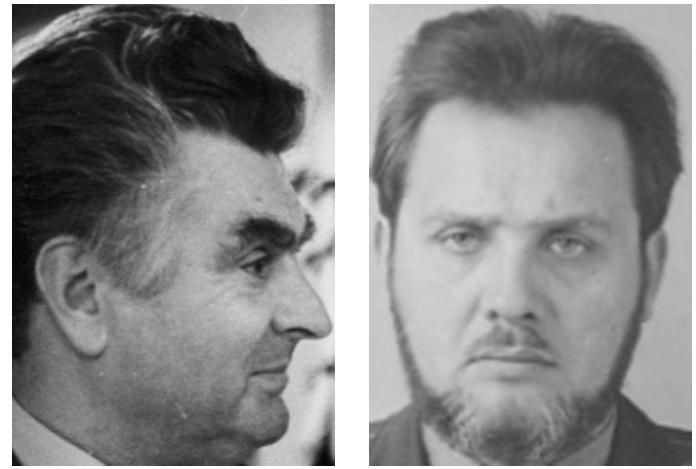
FIGURE 11. Some individual variants of dapple location of gray hair flecks in a temple (left) and a beard